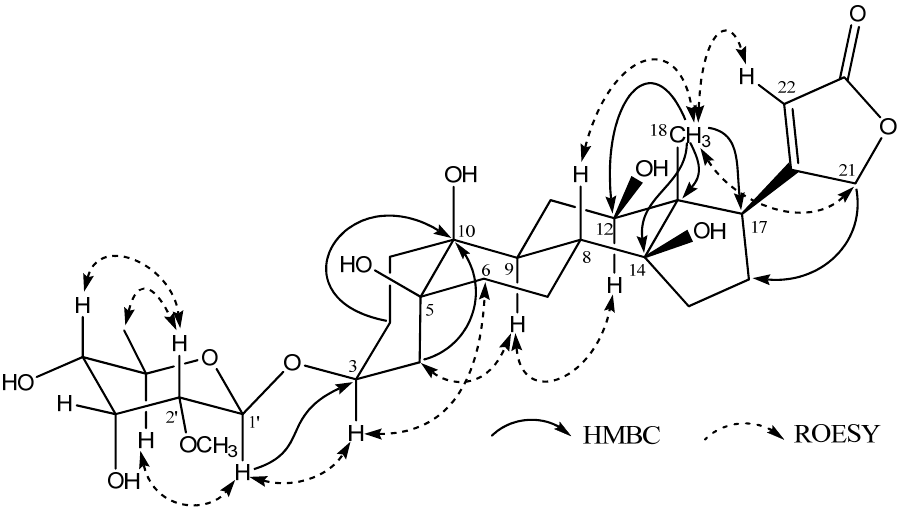
Figure 2. Key HMBC and ROESY interactions for compound 1